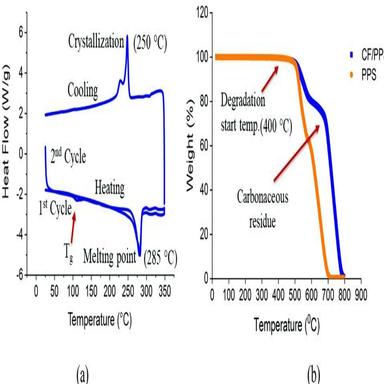
Thermal analysis results; (a) DSC of CF-PPS pellets, and (b) TGA analysis of PPS matrix and CF-PPS pellets.